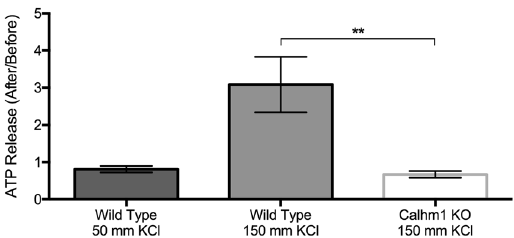
Figure 4. Apical ATP release 15 seconds after addition of 50 or 150 mM KCl in wild type and Calhm1 knockout cultures. Bars are means ± SE of 3–5 cultures each. * p < 0.05, ** p < 0.01, Kruskal-Wallis with Dunn’s multiple comparisons